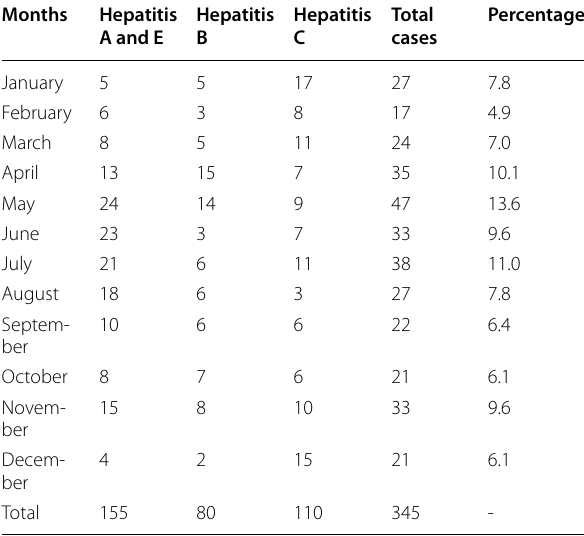
Table 2 Prevalence of different types of viral hepatitis in indoor patients in the District Dera Ismail Khan, Khyber Pakhtunkhwa, in